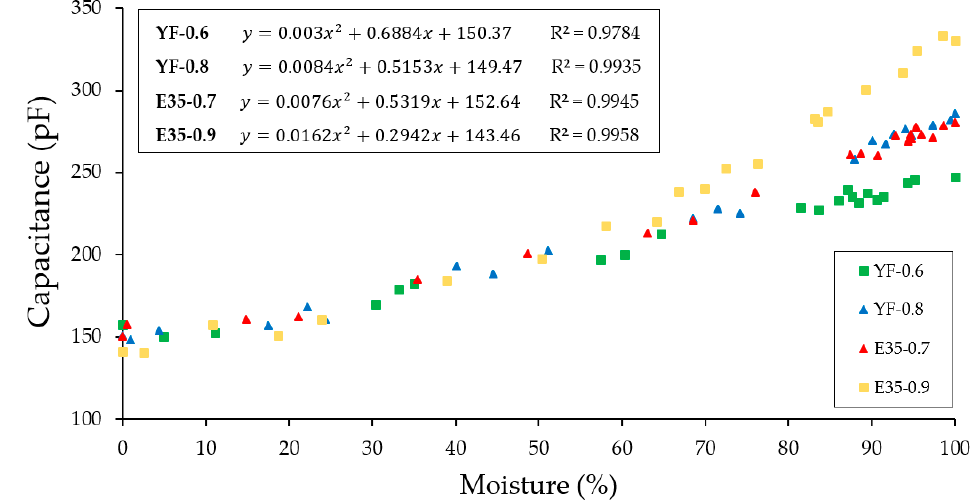
Figure 14. Capacitance values versus the moisture content of the test specimens.